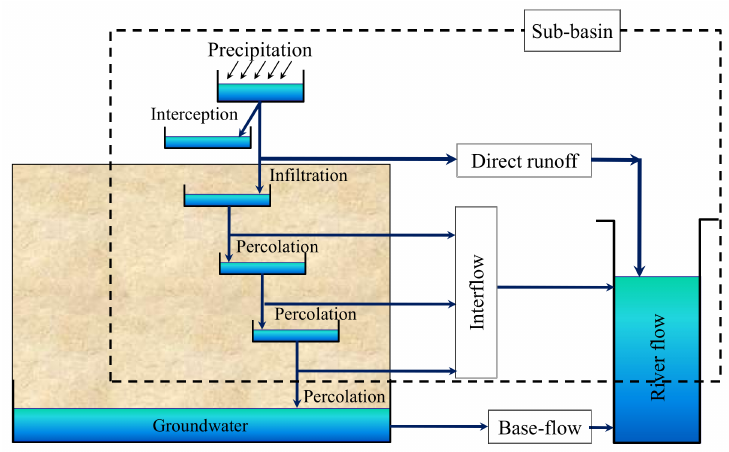
Figure 1. Schematic of the super-tank model, modified after